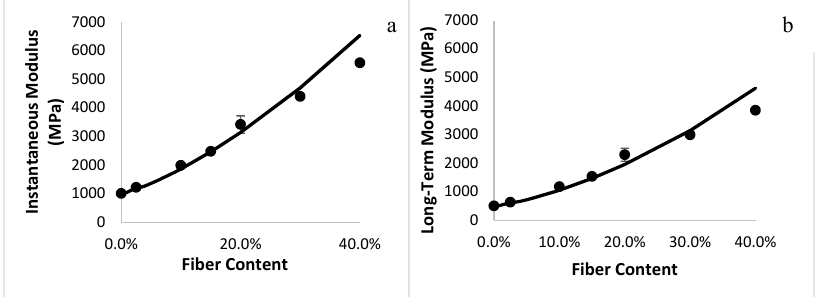
Figure 4. Good agreement is obtained between the instantaneous ( a ) and long-term ( b ) moduli values obtained from the analytical model (-) and the finite element simulations ( ● ).